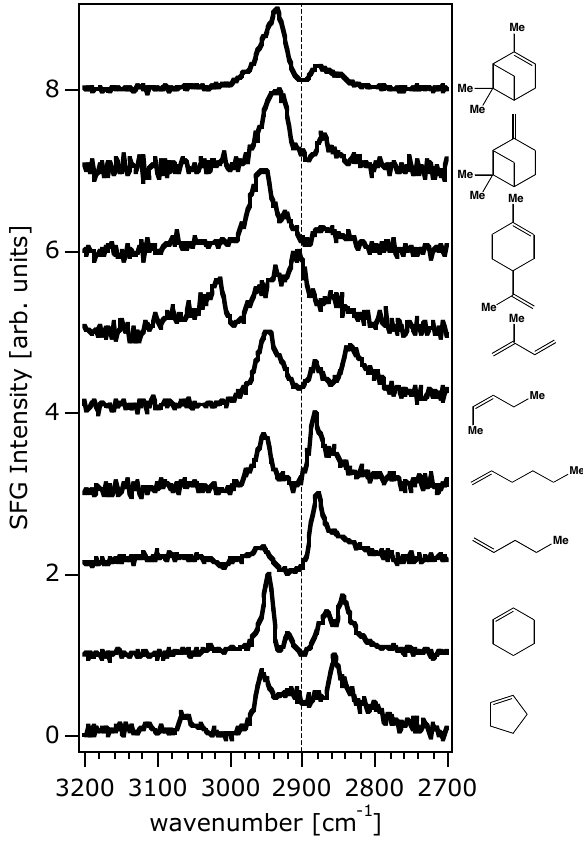
Fig. 2. SSP-Polarized vibrational SFG spectra of an optical win- dow in contact with the equilibrium organic vapor at room tem- perature of (top to bottom) α -pinene, β -pinene, limonene, isoprene, cis-2-pentene, n-hexene, n-pentene, cyclohexene, and cyclopentene. All spectra normalized to the highest peak intensity, and offset for clarity. The vertical dashed line at 2900cm − 1 dissects the fre- quency location of asymmetric and symmetric CH stretching modes of aliphatic hydrocarbon species to the left and right of it, respec-